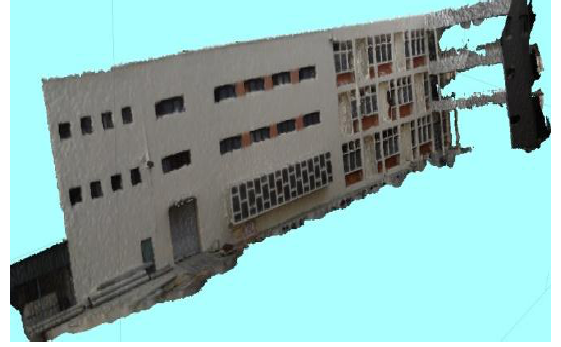
Figure 9: Solid model generation